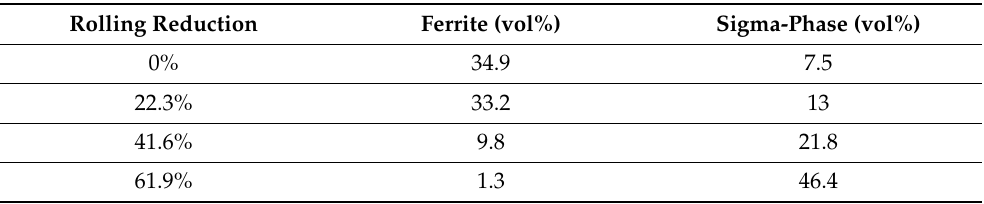
Table 2. The ferrite and sigma-phase content of the specimens after a rolling reduction of 0%, 22.3%, 41.6%, and 61.9%, and heat treatment of 850 ◦ C for 30